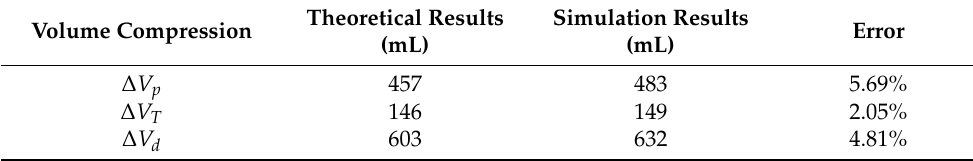
Figure 12. The pressure-induced deformation of pressure hull under different parameters. Table 5. Compression of the deformation caused by pressure and temperature.